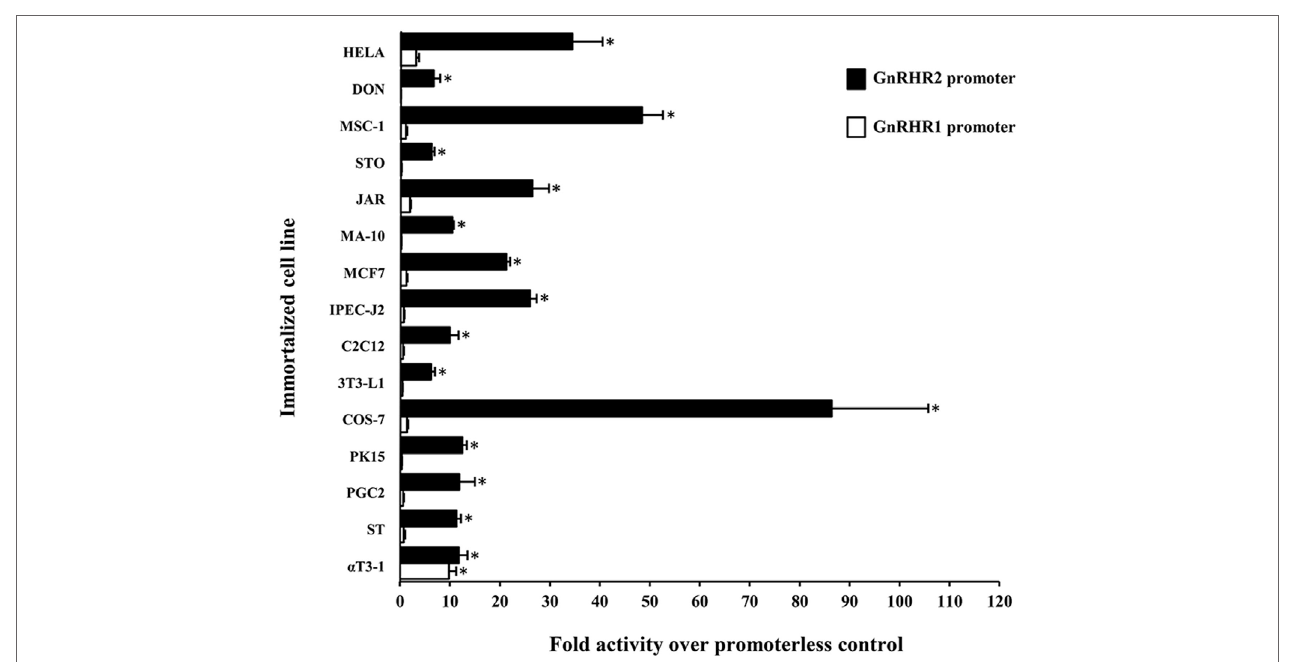
FiGURe 3 | Activity of the porcine GnRHR1 and GnRHR2 gene promoters within different mammalian cell lines. Cells were transiently transfected with either the porcine GnRHR1 (white) or GnRHR2 (black) gene promoter in a luciferase reporter vector and expressed as fold activity over the promoterless control. Abbreviations: HELA, human cervical cancer; DON, Chinese hamster lung; MSC-1, mouse Sertoli cell; STO, mouse embryonic fibroblast; JAR, human placenta; MA-10, mouse Leydig cell; MCF7, human breast cancer; IPEC-J2, piglet intestinal epithelium; C2C12, mouse muscle myoblast; 3T3-L1, mouse adipocyte fibroblast; COS-7, green monkey kidney; PK15, porcine kidney; PGC-2, porcine granulosa cell; ST, swine testis; and α T3-1, murine gonadotrope. An asterisk indicates Least Squares Means that are significantly greater than the promoterless control ( P < 0.05). Reprinted from Brauer et al. (75) with permission from Elsevier.